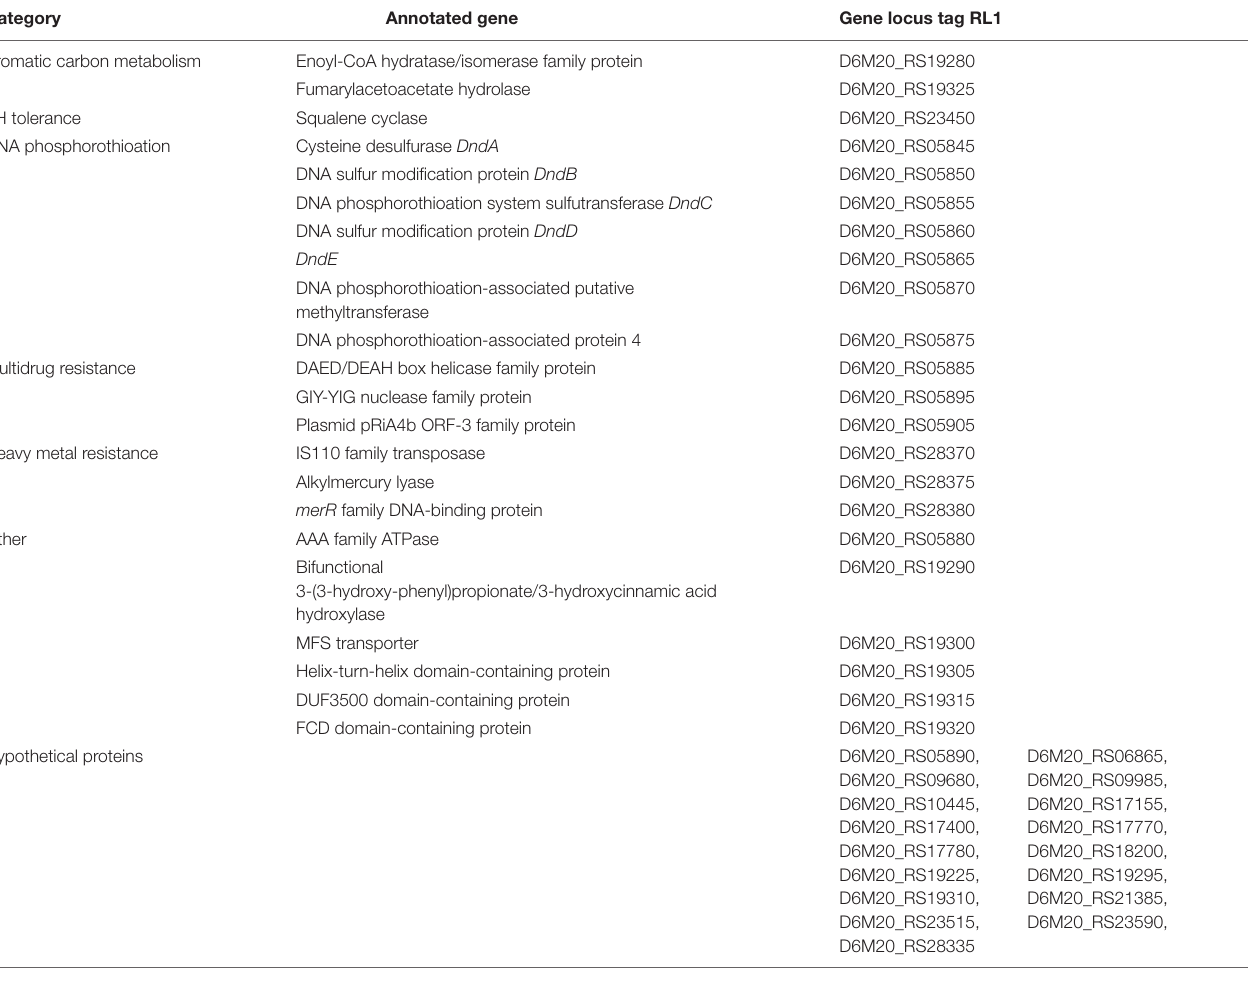
TABLE 1 | Singleton genes RL1 based on genome comparison with BG43 and djl6 in EDGAR. Category